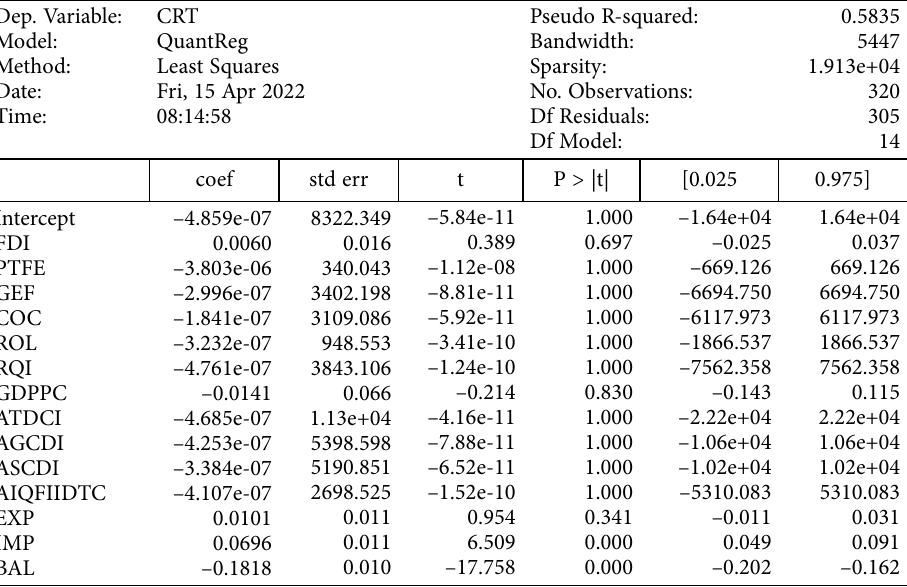
Table 11. QuantReg regression results – Part 1 (source: own processing using Python 3.0 software)